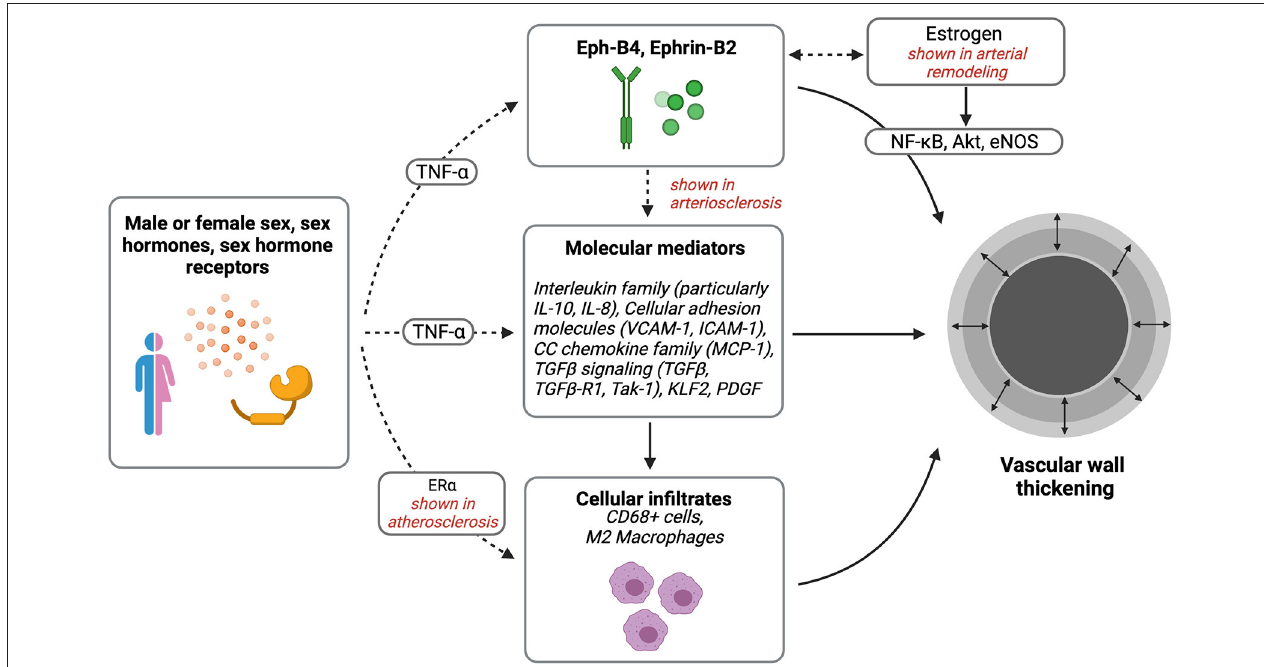
FIGURE 2 | Sex differences in vascular wall thickening. Potential pathways of interest in vessel wall thickening that may be affected by sex, sex hormones, and sex hormone receptors. Created with